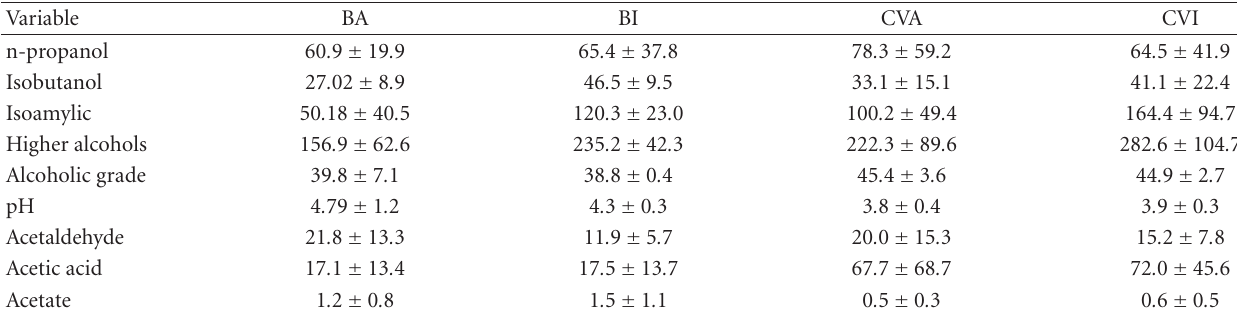
Table 2: Concentrations (mg/100 mLAA ∗ ) of compounds in Cape Verde and Brazilian spirits.